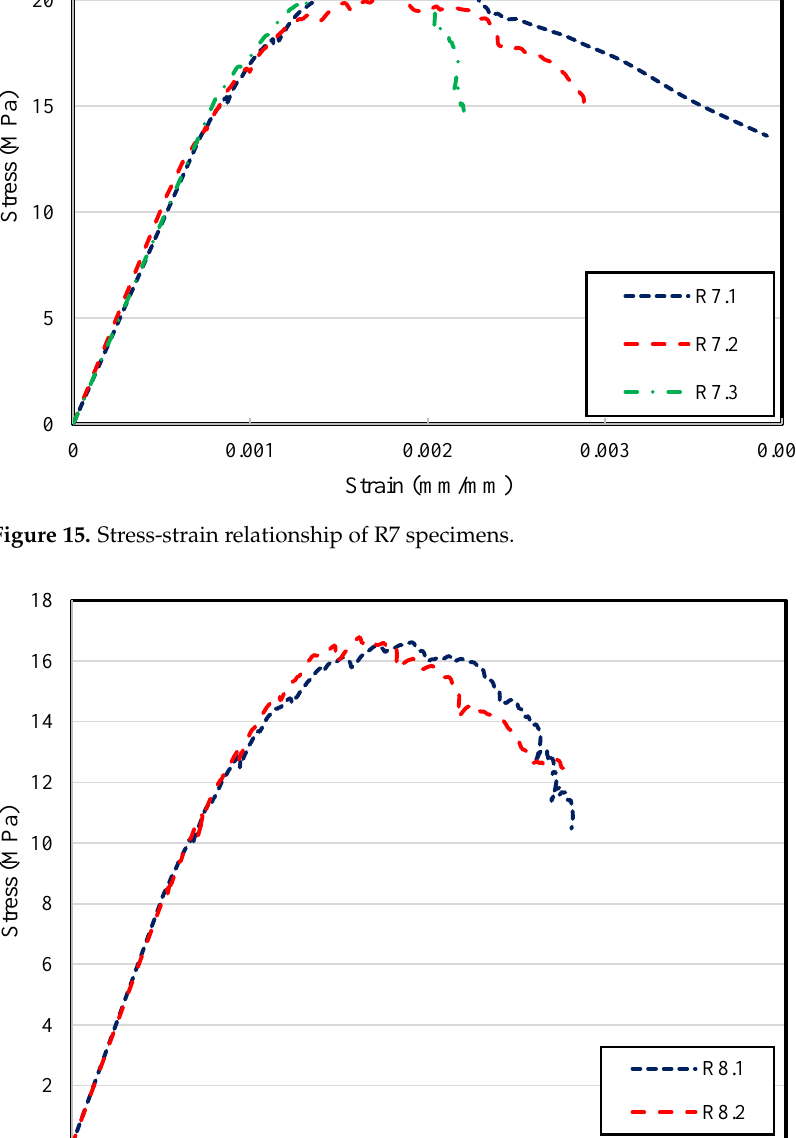
Figure 16. Stress-strain relationship of R8 specimens.